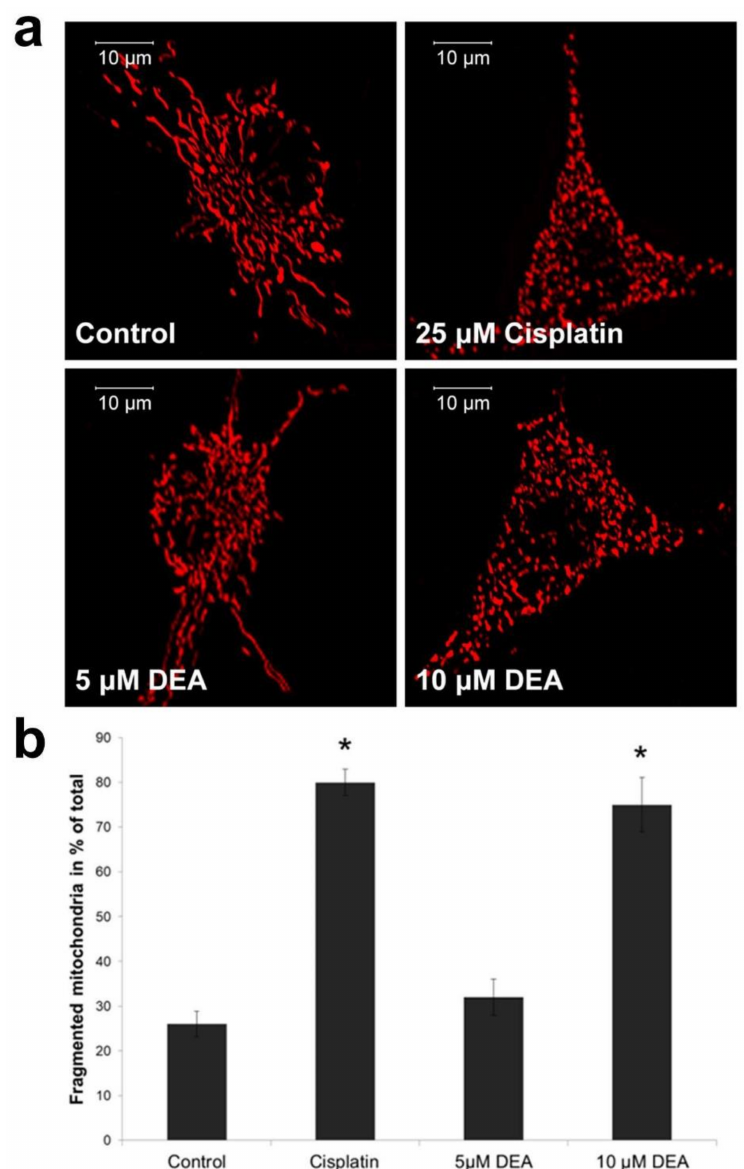
Figure 3. E ff ect of DEA on mitochondrial fragmentation. mtRFP-transfected cells were treated with 5 or 10 µ M of DEA, or 25 µ M of cisplatin (positive control [24]), for 3 h. Mitochondrial fragmentation was determined based on confocal fluorescence images, as described in [25]. ( a ) Representative fluorescence images for all the treatment groups. ( b ) Quantitative assessment of mitochondrial fragmentation expressed as % (means ± SEM of three independent experiments). * indicates a significant di ff erence relative to the control ( p <